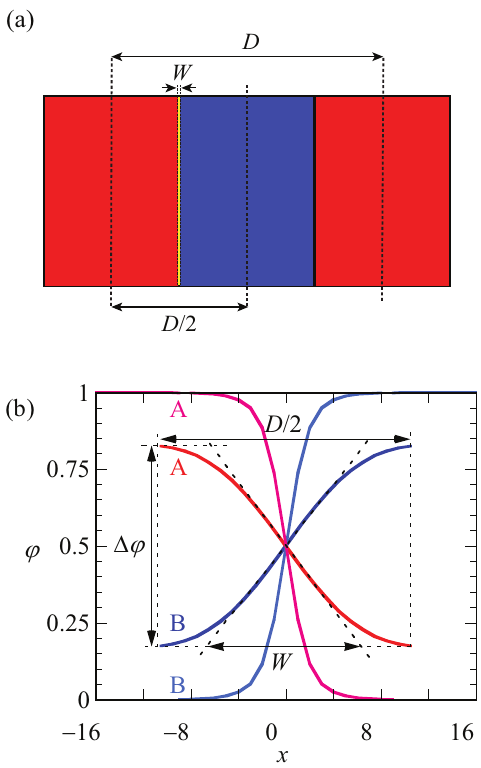
Figure 2. ( a ) Schematic representation of symmetrical LAM phase. Red and blue regions indicate blocks of A and B, respectively. The lamellar spacing D and the width of the interface W are indicated; ( b ) SF-SCF density profiles ( ϕ ) as a function of layer number x where x = 0 is taken halfway the A–B interface. Parameters: f = 0.5 and N = 1000; red and blue lines are for weak segregation χ N = 12, optimal spacing is D /2 = 21 of A and B blocks, respectively, and pink and light blue lines are for strong segregation χ N = 75, D /2 = 31 of A and B blocks, respectively. The parameters ∆ ϕ , D and W are stated for χ N =